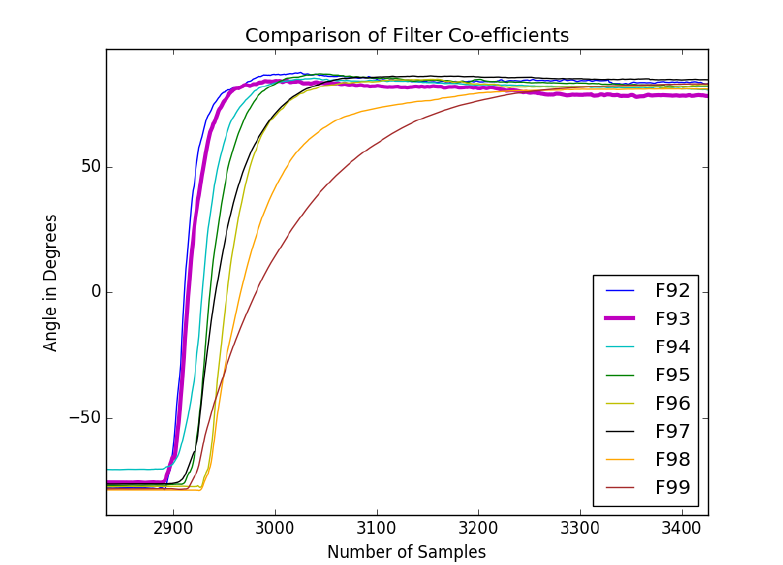
Figure 7. Comparison of eight different gyroscope to acceleration ratios for the complementary filter. The ratio is computed in the range 91 < X < 100 with X